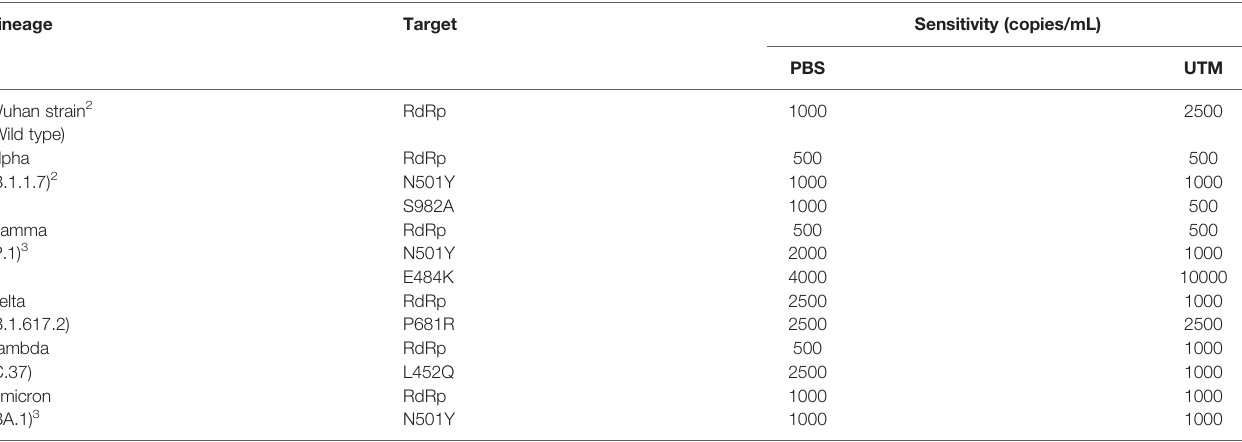
TABLE 2 | Assay sensitivity for the detection of targeted spike gene mutations 1